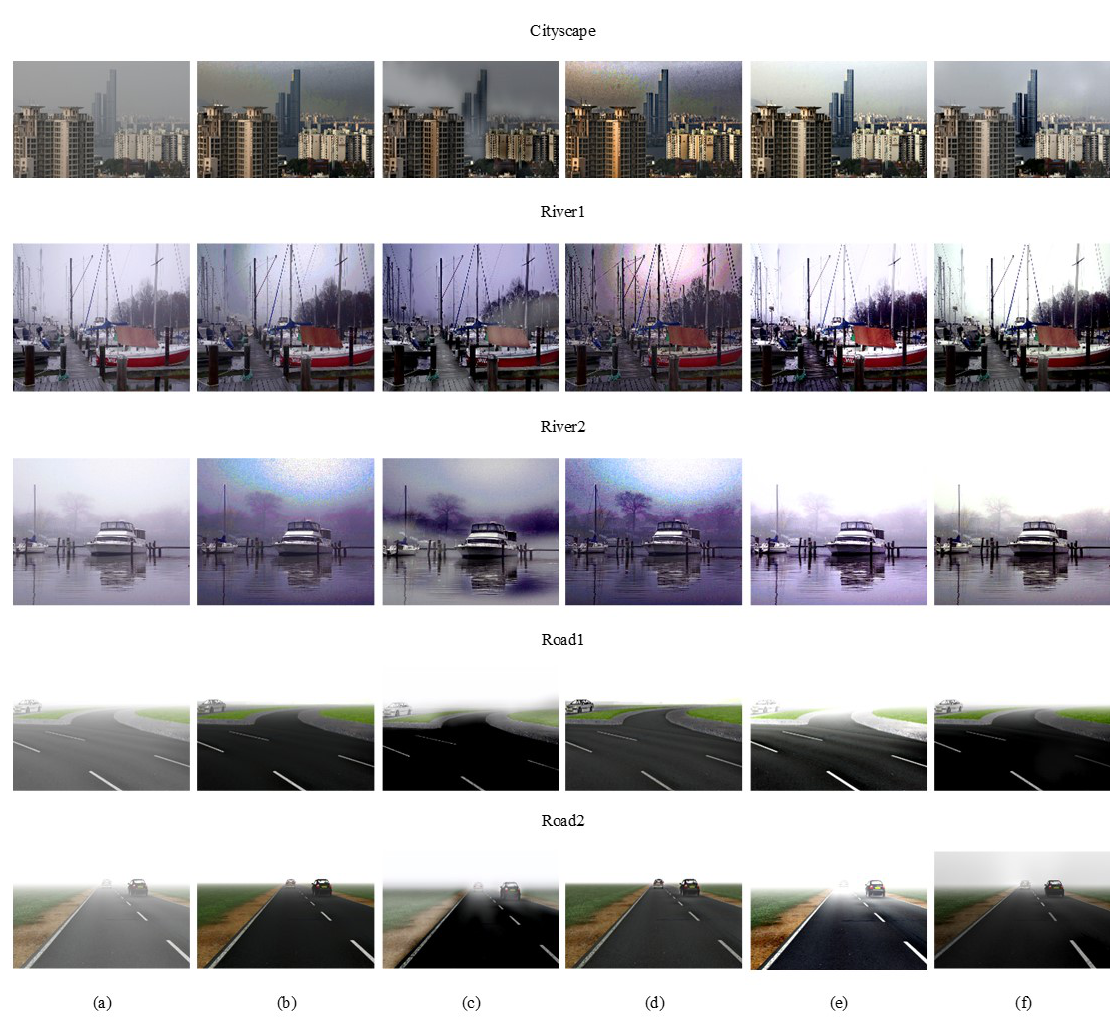
Figure 7. Experimental results of various defogging methods. ( a ) Input foggy images; ( b ) He et al. [7]; ( c ) Ancuti et al. [14]; ( d ) Meng et al. [13]; ( e ) Berman et al. [15]; ( f ) the proposed